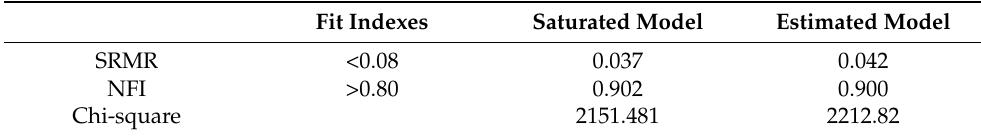
Table 7. Model Fit.